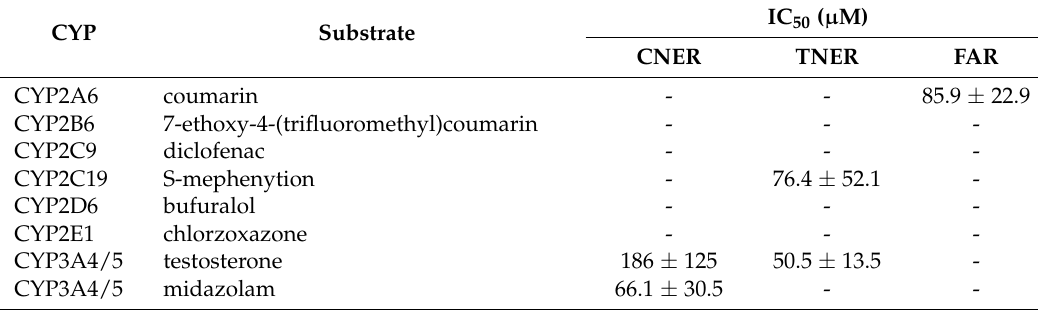
Table 3. Inhibition concentration (IC 50 ) of sesquiterpenes CNER, TNER and FAR to CYP2A6,